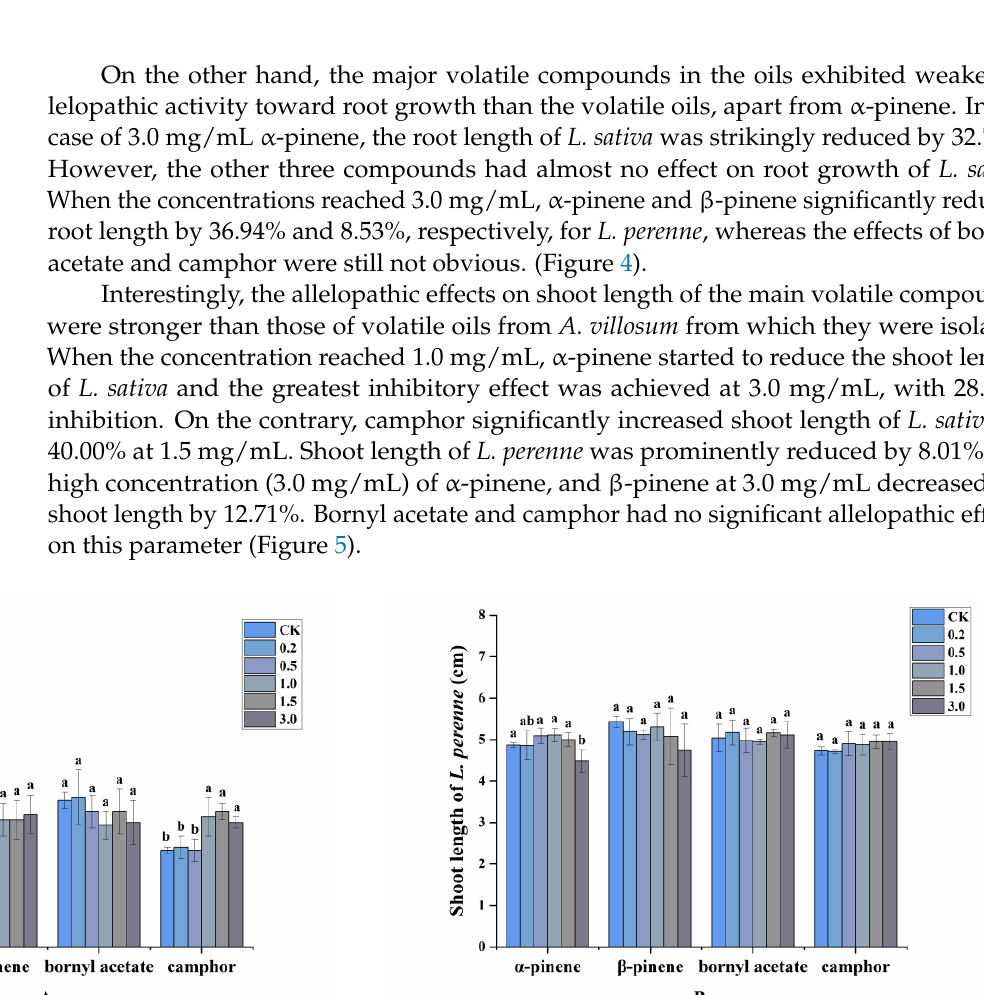
Figure 4. Allelopathic effects of four main volatile compounds on the root length of ( A ): L. sativa and ( B ): L. perenne . Each value is the mean of five replicates ± SD ( n = 30). Means with different lowercase letters indicate significant differences at p < 0.05 level according to ANOVA and Fisher’s LSD test.